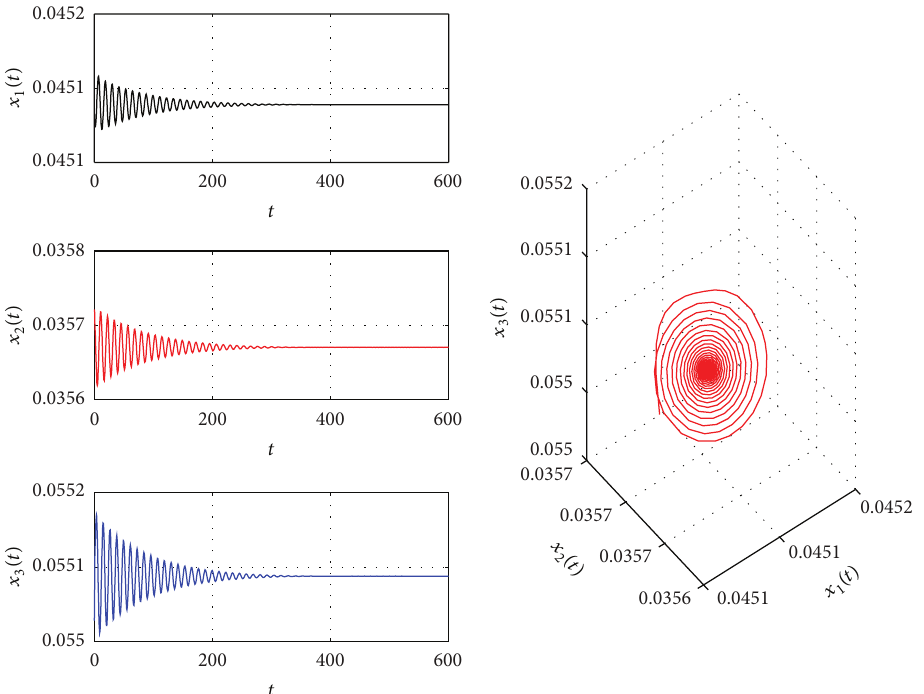
= 3.2348 ; 𝐸 ∗ is locally asymptotically stable. 0